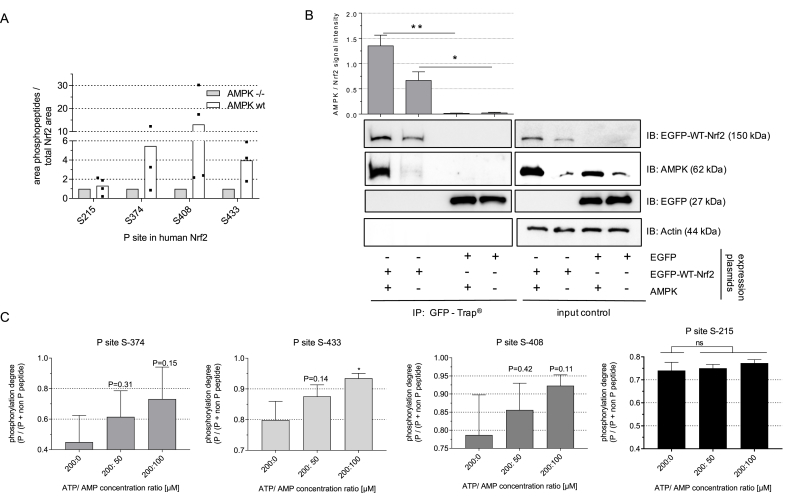
Nrf2 is AMPK-dependently phosphorylated at serine 374, 408 and 433, interacts with AMPK and is an AMPK substrate. (A) AMPK wt or AMPKα1 −/− MEF were transiently transfected with EGFP-WT-Nrf2 and treated with AMPK activator A769662 (50 μM, 4 h) and proteasome inhibitor (MG132, 20 μM). Accumulated Nrf2 was pulled down from cell lysates and after tryptic/chymotryptic digestion subjected to LC-MS analysis and screened for AMPK-dependent phosphosites. For S 374, 408 and 433 the relative amount (area by LFQ) of phosphosite specific peptides normalized to the total amount of Nrf2 is shown for WT and AMPKα1 −/−MEF (S 215 depicted as presumably AMPK independent site). Dots show the obtained area in single biological replicates, bars indicate the mean. (B) HEK cells were transfected with expression plasmids for EGFP-WT-Nrf2, PRKAA1 (AMPK) or EGFP as indicated. After stabilization of Nrf2 (via proteasome inhibition), lysis and pulldown via GFP-Trap®, eluates as well as an aliquot (20 μg protein) of the unprecipitated lysate (input control) were immunoblotted for GFP (= EGFP-WT-Nrf2 or EGFP) or AMPKα1. Representative blots and compiled densitometric analyses (AMPK signal/GFP signal) are depicted (n = 3, unpaired Student's t-test, two tailed, α = 0.05, *P < 0.05). (C) Recombinant AMPK and Nrf2 were subjected to an in vitro kinase assay with varying ratios of ATP to AMP (as indicated, fixed ATP concentration of 200 μM). After termination of the reaction, Nrf2 was prepared for and subjected to MS analysis for phosphosite identification and quantification. The obtained area of the most abundant peptide of Nrf2 for each indicated phosphosite was normalized as follows: [area P peptide/(area P peptide + area same peptide without phosphorylation)], which gives the degree of phosphorylation. A value of 1 would indicate that 100% of the detected peptide was phosphorylated at that position and no unphosphorylated peptide was found. (n = 3, mean +SD, unpaired Student's t-test, two tailed, α = 0.05, *P < 0.05, ns: not significant).